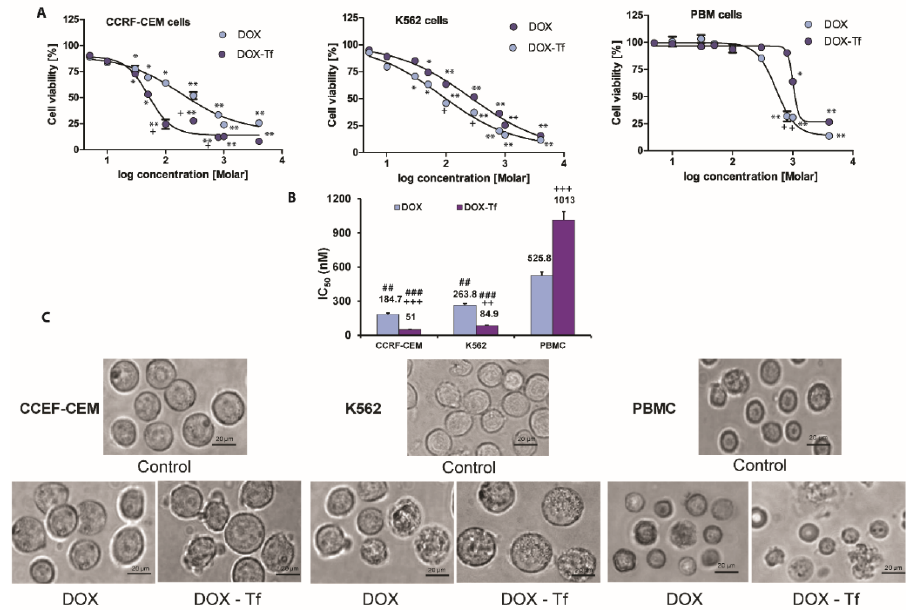
Figure 1. Cytotoxicity of free doxorubicin and doxorubicin–transferrin conjugate in human leukemia cell lines and peripheral blood mononuclear cells. ( A ): Viability of CCRF-CEM, K562, and PBMC cells after 48 h incubation with increasing concentrations of doxorubicin–transferrin (DOX–Tf) conjugate (violet symbols) or free doxorubicin (DOX) (blue symbols). Cell viability was measured by XTT assay. Values represent the means ± SD, ( n = 5) * p < 0.05, ** p < 0.01 in comparison to untreated, control cells, (+) statistically significant differences noted between the probes incubated with free DOX compared